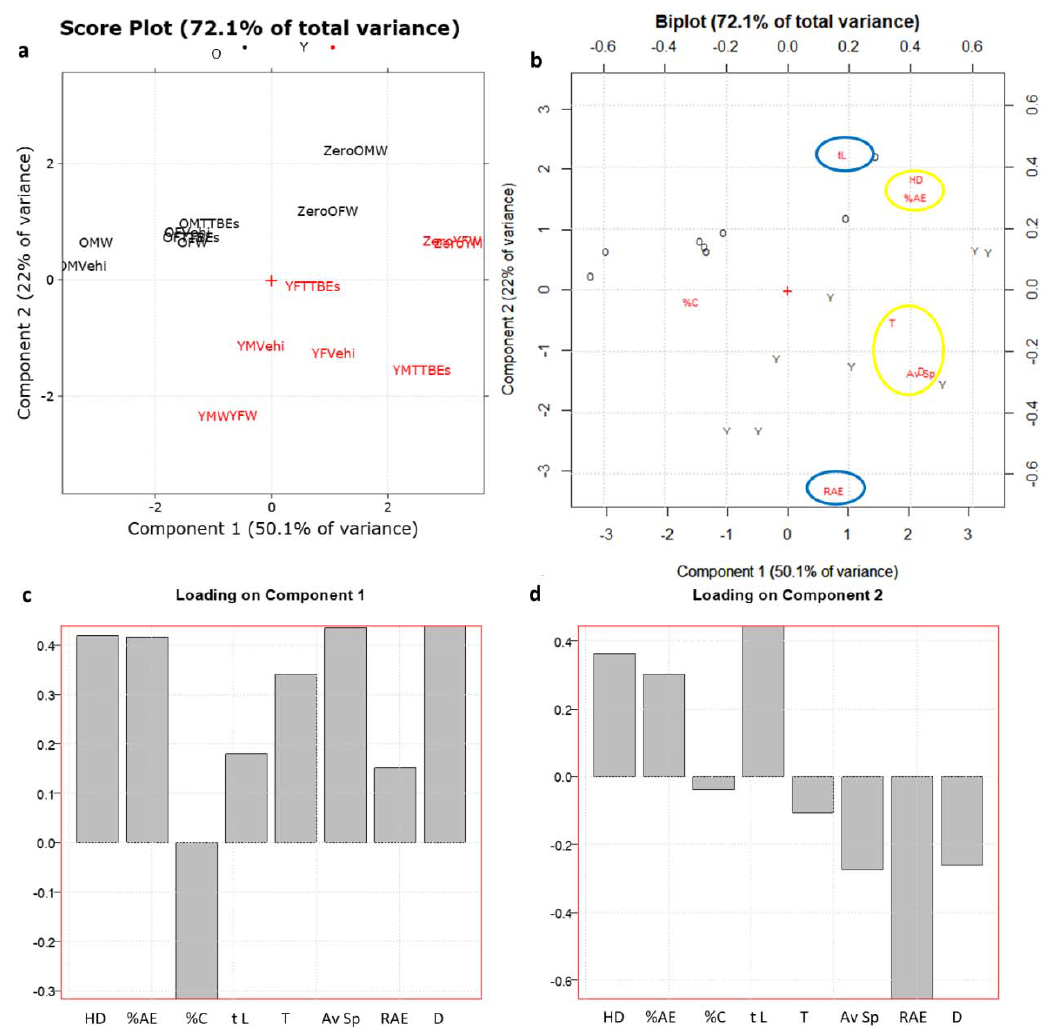
Figure 4. ( a ) PC1-PC2 score plot and biplot of the D 16,8 data matrix. ( b ) PC1-PC2 biplot (scores plus loadings plot). Animals are categorized by age: old mice are reported in black and young ones in red, respectively. ( c ) Loading plot on PC1. ( d ) Loading plot on PC2. YMW: young male water, YFW: young